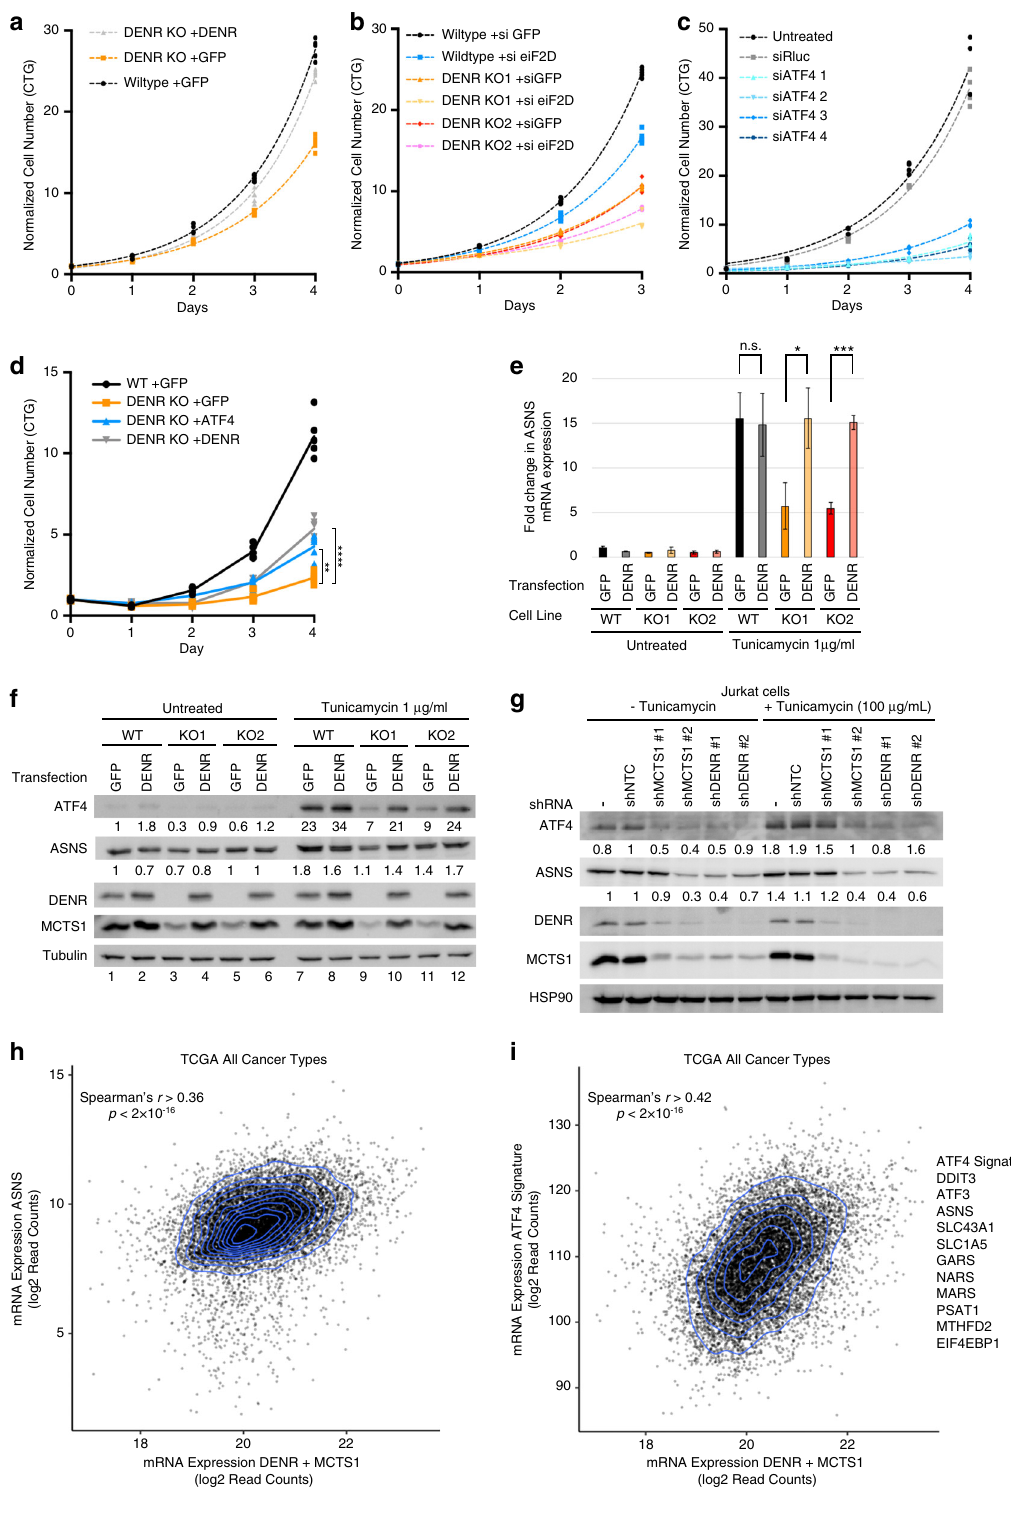
selected using 1 µg/ml puromycin for 2 – 3 days. Then cells were grown out and seeded at limiting dilution and clones were screened for successful knockout by immunoblotting. Successful knockout was then also assessed by sequencing the edited genomic region after PCR ampli fi cation and TOPO cloning. Lentiviral transduction . Lentiviral plasmids were generated by introducing the following sequences into the Cellecta backbone pRSI21-U6-sh-HTS6-CMV- TagGFP2-2A-Puro by oligo cloning: nontarget shRNA (CAACAAGATGAAG NATURE COMMUNICATIONS| (2020) 11:4676